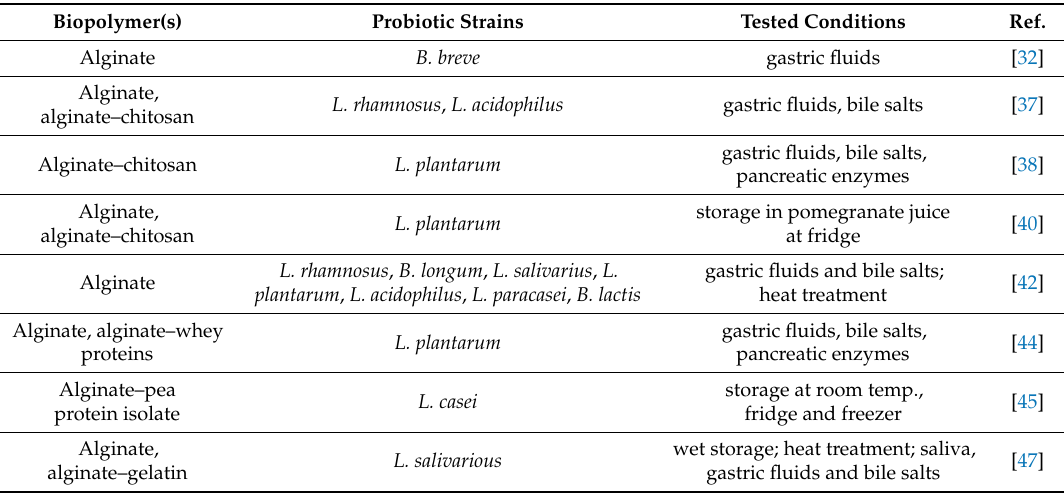
Table 1. Alginate-based hydrogels used as delivery systems of selected probiotic